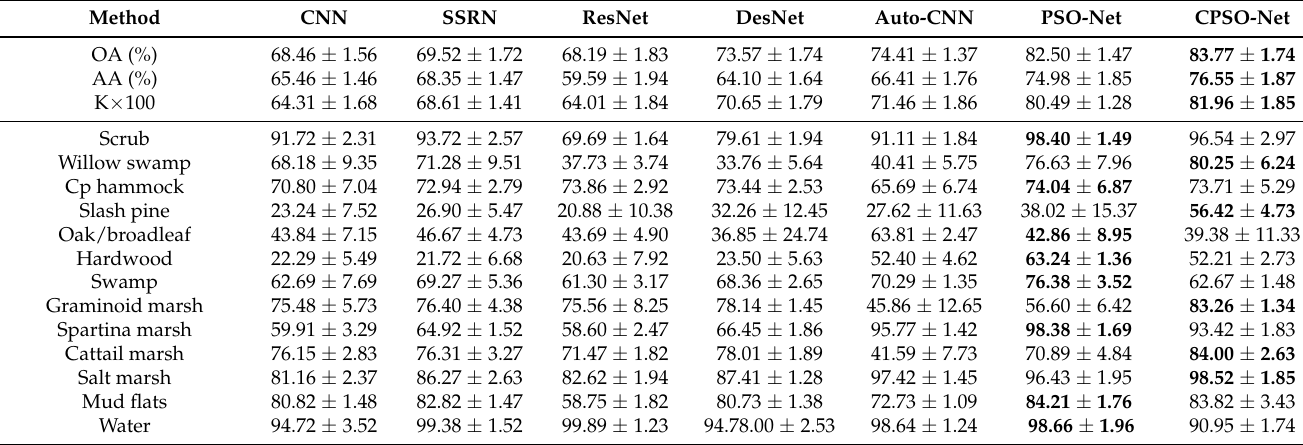
Table 11. Classification accuracy with bolding the best accuracy based on the unbiased KSC dataset, run five times.